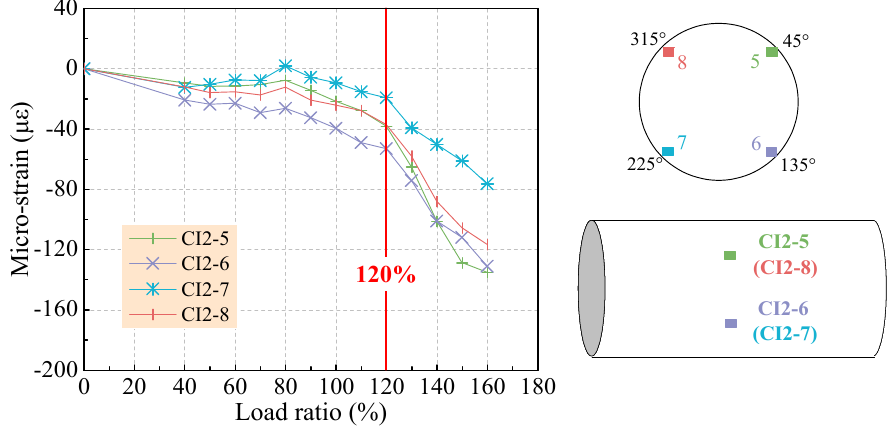
Figure 12. The load-strain relationship of the concrete between crown/invert and springing line (45°,135°,225° and 315°).